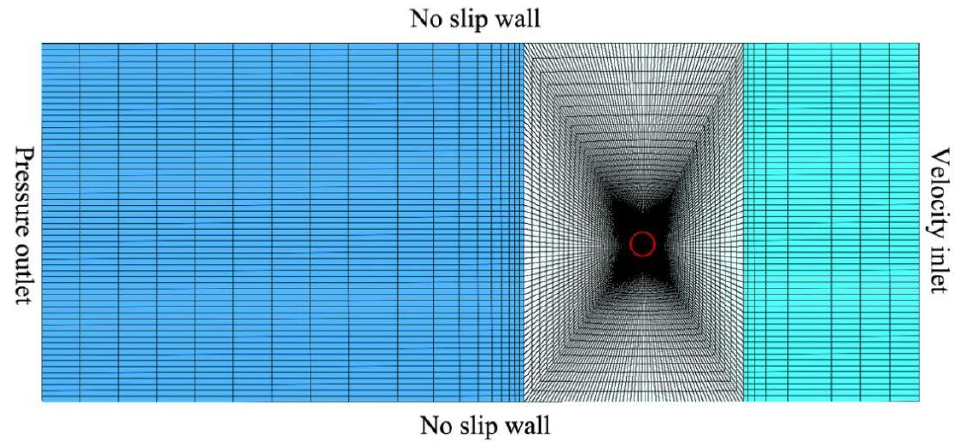
Figure 7. Single helical tube calculation model and grid division.